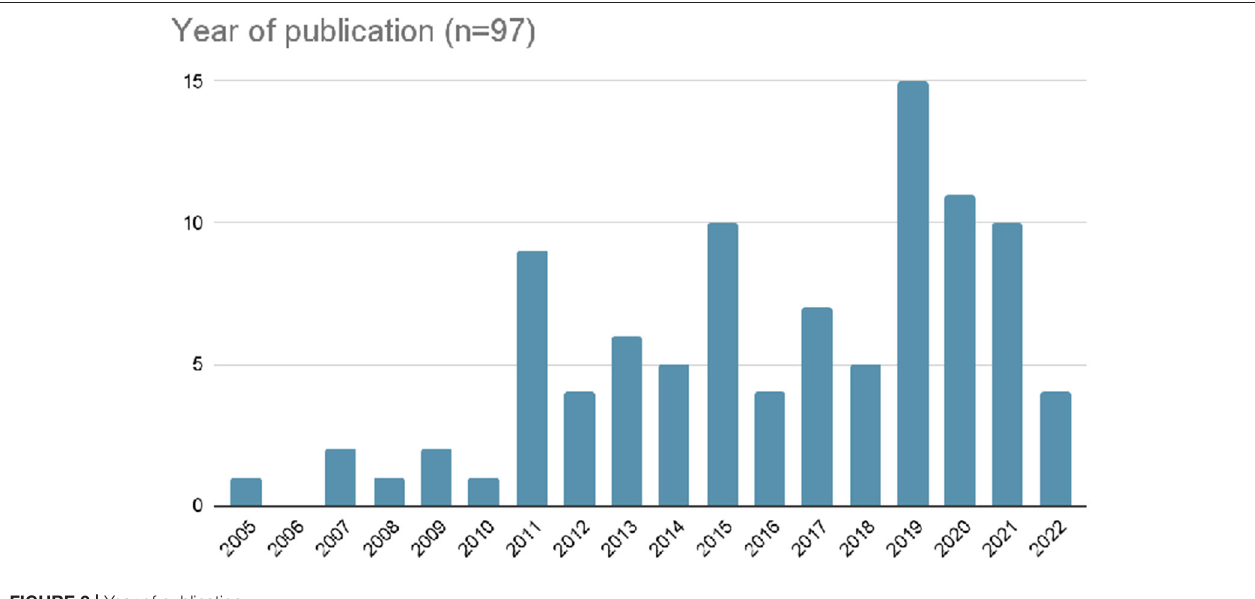
FIGURE 2 | Year of publication.